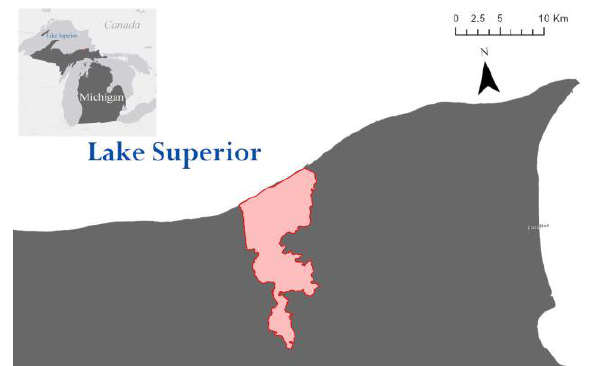
Figure 1. Study Area Overview